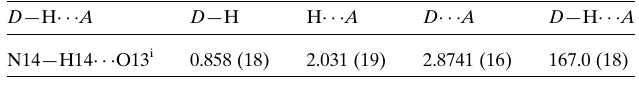
Table 1 Hydrogen-bond geometry (A˚ , (cid:2) ).